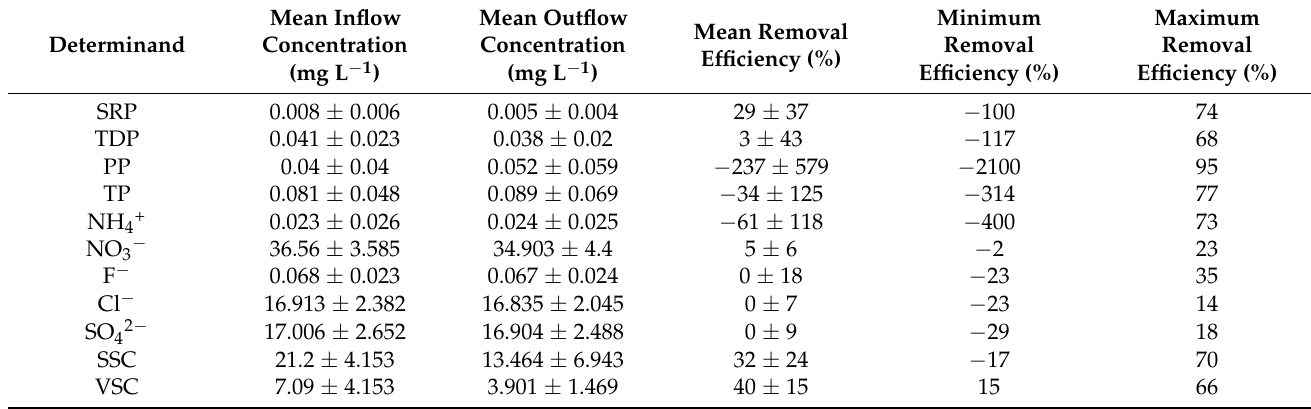
Table 1. Mean ( ± SD) inflow and outflow concentrations (mg L − 1 ), and mean ( ± SD), minimum, and maximum removal efficiency (%) of the on-line pond system for water quality determinands sampled during (near) baseflow conditions.